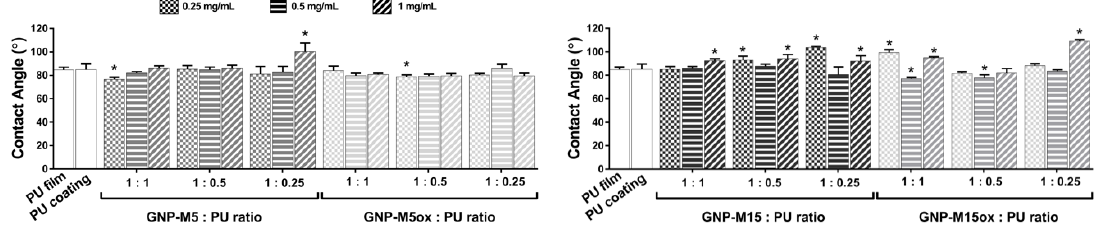
Figure 6. Characterization of PU/GNP coatings: surface wettability of PU (control) and PU/GNP coatings with different GNP concentration and GNP:PU ratio, obtained by water optical contact angle measurements. * statistically significantly different from control (PU) (one ‐ way ANOVA; p ≤ 0.05). Surface chemistry of the PU/GNP coatings was further explored using XPS and Raman spectroscopy, being PU/GNP coatings with intermediate GNP concentration (0.5 mg/mL) and